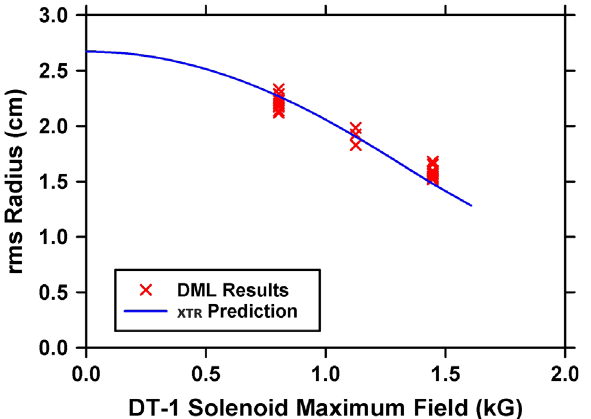
lines.FIG. 10. Average excluded flux as a function of DML bias field for the three peak fields of the DT-1 focusing solenoid. Dotted lines are least-square fits of linear dependence on the bias field.